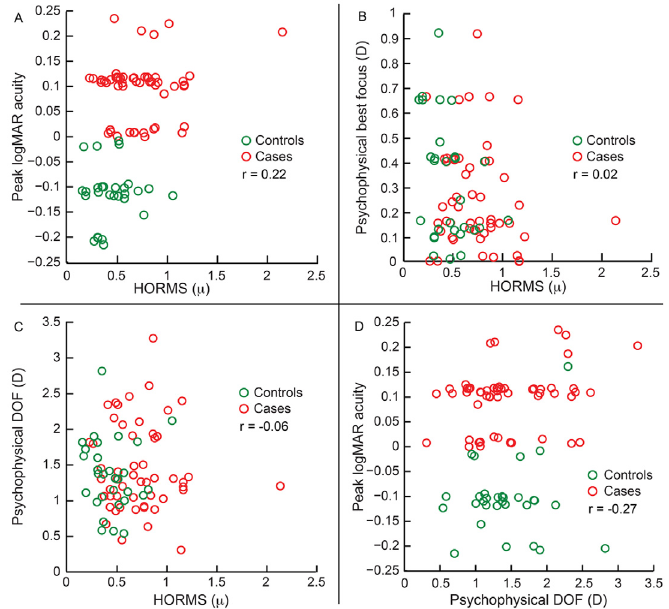
Fig 5. Relation between peak high contrast logMAR acuity, psychophysical best focus, psychophysical high contrast DOF and HORMS obtained from the first arm of the study. All other details are similar to Fig 3.